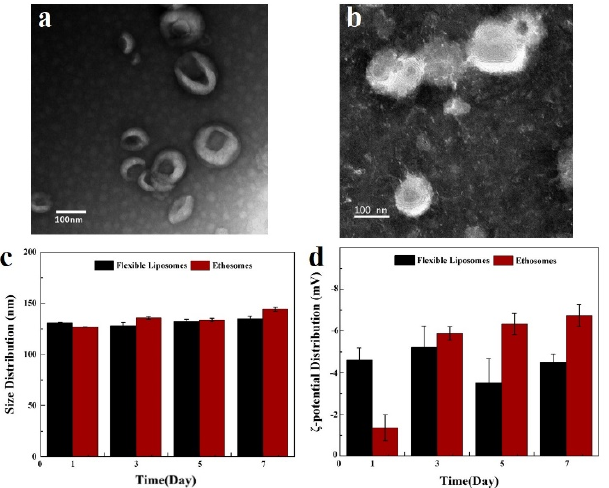
Figure 6. Visualization and characterization of ethosomes and flexible liposomes. ( a ) TEM image of ethosomes. ( b ) TEM image of flexible liposomes. ( c ) Particle size profiles of ethosomes and flexible liposomes over 7 days at 4 °C. ( d ) ζ -potential profiles of ethosomes and flexible liposomes over 7 days at 4 °C.